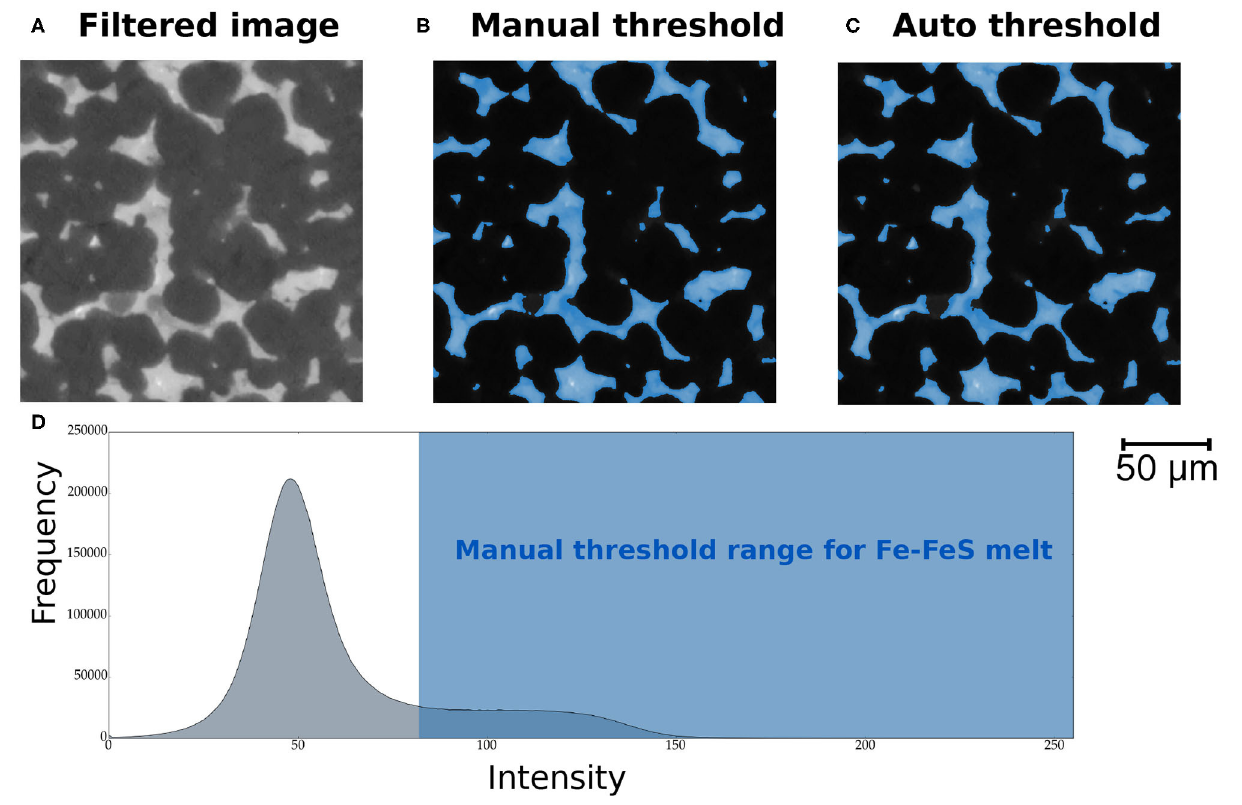
FIGURE 2 | Comparison between manual and auto threshold techniques using a 2D slice from sample OFS-10 – subvolume 1. Panel (A) shows the image filtering result using the non-local means technique. The segmentation of the melt distribution using the manual threshold is shown in (B) , while the results of auto threshold are shown in (C) . (D) A representative histogram from a 2D slice of sample OFS-10. The pronounced peak near the intensity of 50 represents gray scale values of olivine grains. The shaded blue region marks the intensity range defined as the melt phase during manual thresholding. Manual threshold ranges for each subvolumes are provided in the Supplementary Material . See text and references therein for more information on the automated thresholding.